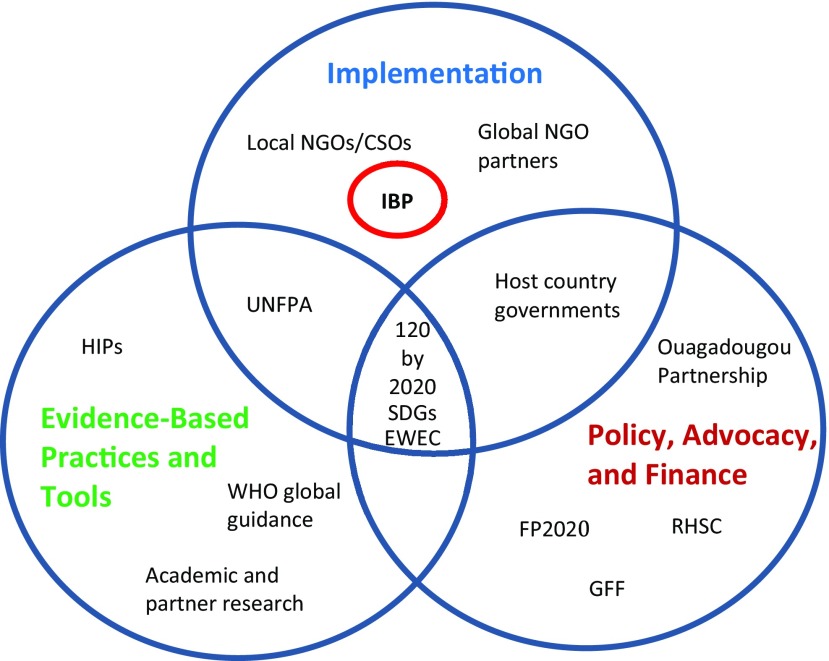
IBP in the Context of Other Development Actors in Family PlanningAbbreviations: CSOs, civil society organizations; EWEC, Every Woman Every Child; FP2020, Family Planning 2020; GFF, Global Financing Facility; HIPs, Family Planning High Impact Practices; IBP, Implementing Best Practices; RHSC, Reproductive Health Supplies Coalition; SDGs, Sustainable Development Goals; UN, United Nations; UNFPA, United Nations Population Fund; WHO, World Health Organization.Note: “120 by 2020” refers to the FP2020 global mandate to reach 120 million more women and girls with voluntary contraception by 2020.